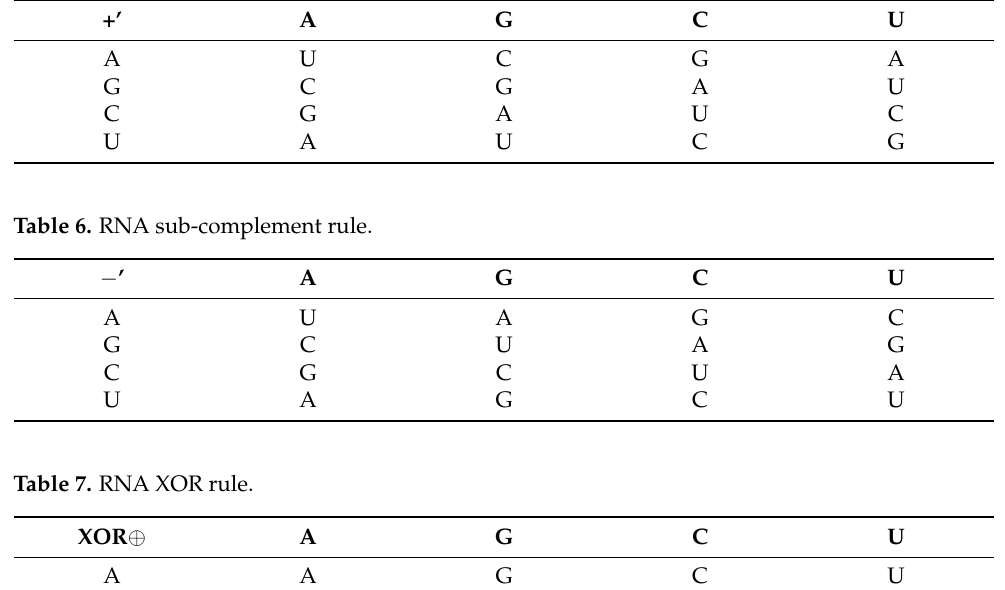
Table 5. RNA add-complement rule.